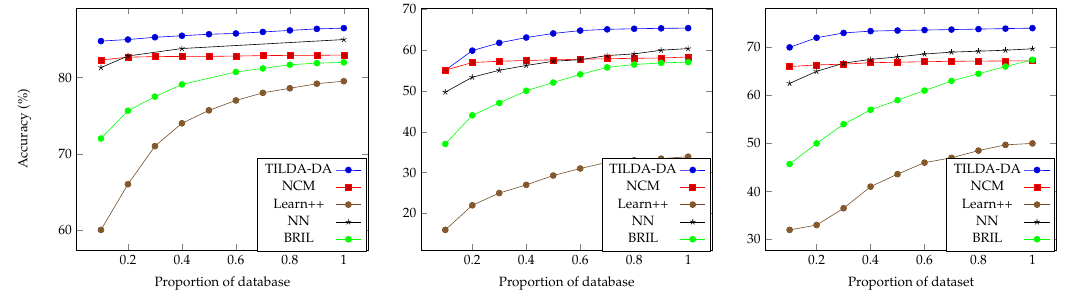
Figure 4. Evolution of the accuracy as a function of number of learning examples for CIFAR10 ( left ), CIFAR100 ( middle ) and ImageNet50 ( right